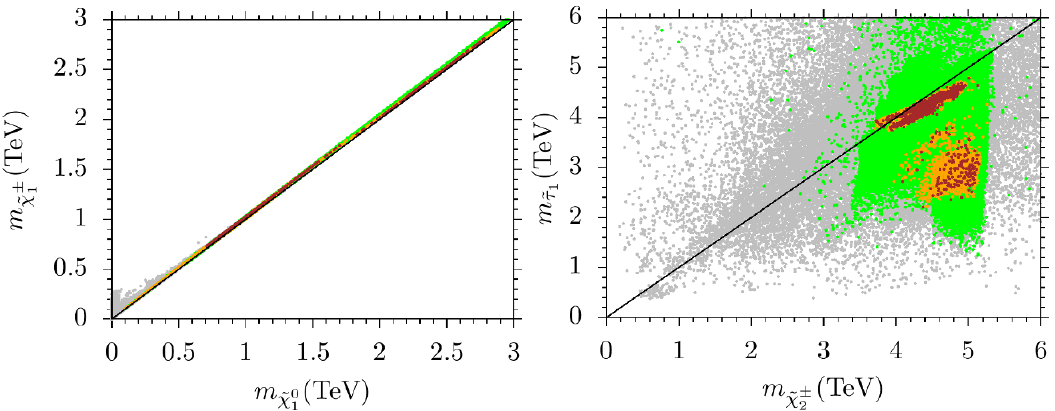
Figure 7 . Plots in the m The diagonal lines indicate the regions predicting mass degeneracy between the